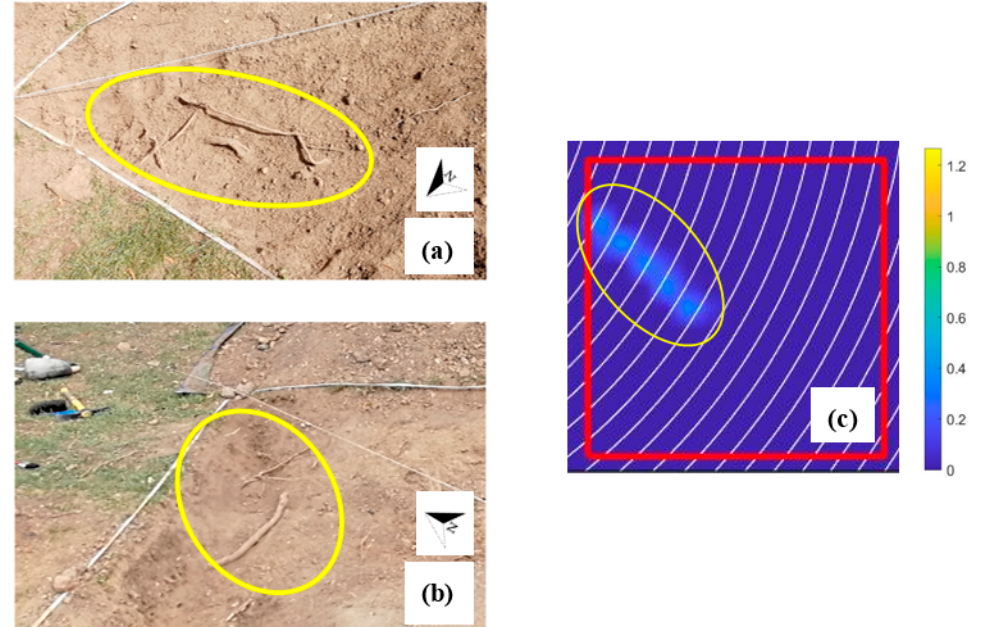
Figure 19. ( a ) The excavated root cluster, and ( b ) a close-up view of the 0.20–0.30 m density map. The yellow circle highlights an area with increased density, corresponding to the cluster of roots.